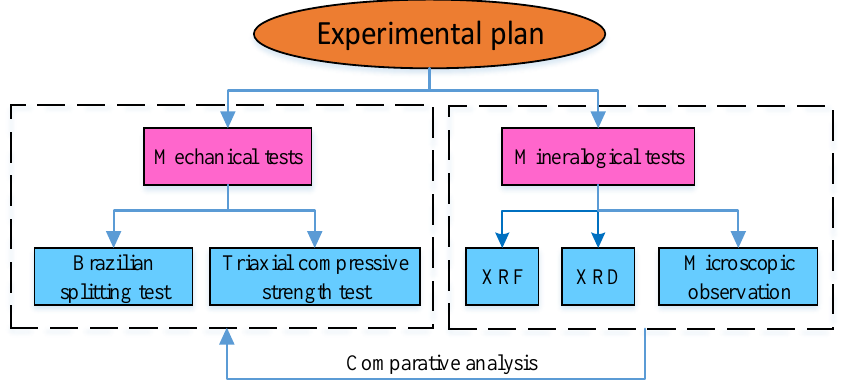
Figure 1. Experimental plan of this study.